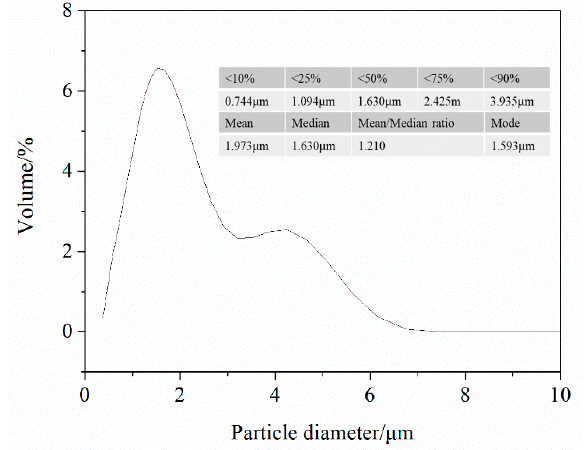
Figure 8. Particle size distribution of the RF thermal plasma synthesized ZrB 2 ‐ ZrC composite powders.